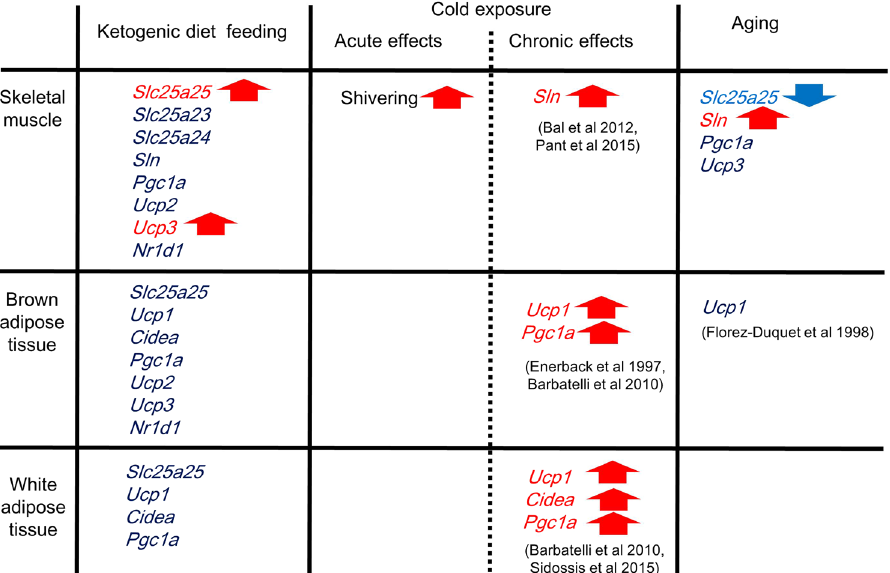
Figure 7. Summary of present study. Mechanism of muscle thermogenesis starts with shivering as first defense against exposure to cold. Thereafter, Sln 22, 50 and Ucp1 51, 52 are respectively driven to elicit non-shivering thermogenesis in skeletal muscle and BAT. Exposure to cold also induces emergence of brown adipocytes in WAT by increasing expression of Ucp1 , Cidea , and Pgc1a genes 52, 53 . Meanwhile, the present study found induced circadian Slc25a25 gene expression in skeletal muscle, but not in BAT and WAT of mice fed with ketogenic diet (KD), which induces torpor. Messenger RNA expression of thermogenesis-related genes such as Ucp1 was not affected by KD in BAT and WAT. Sciatic denervation abolished Slc25a25 expression and augmented KD-induced hypothermia. These results suggest that skeletal muscle is involved in thermogenesis during KD feeding, and that Slc25a25 and Ucp3 are candidates for muscle thermogenesis. Less Slc25a25 was expressed in skeletal muscle of aged, compared with adult mice, whereas Ucp1 expression was not altered by aging at thermoneutrality 54 . SLC25A25 might help to maintain Tb in aged